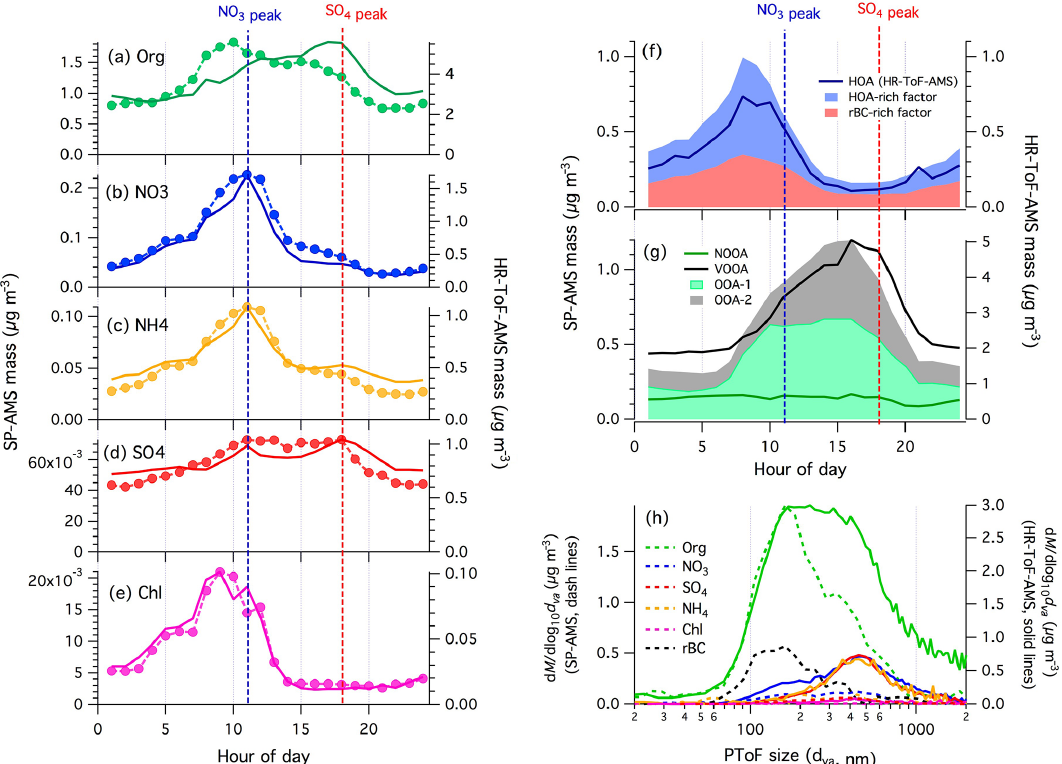
Figure 5. (a–e) Diurnal cycles of NR-PM and NR-PM rBC measured with the HR-ToF-AMS (solid lines) and SP-AMS (dashed lines with circles), respectively. (f–g) Diurnal cycles of PMF factors from HR-ToF-AMS (solid lines) and SP-AMS (filled areas, organic components only for PMF factors) data. (h) PToF size distribution of rBC, NR-PM (dashed lines), and NR-PM rBC (solid